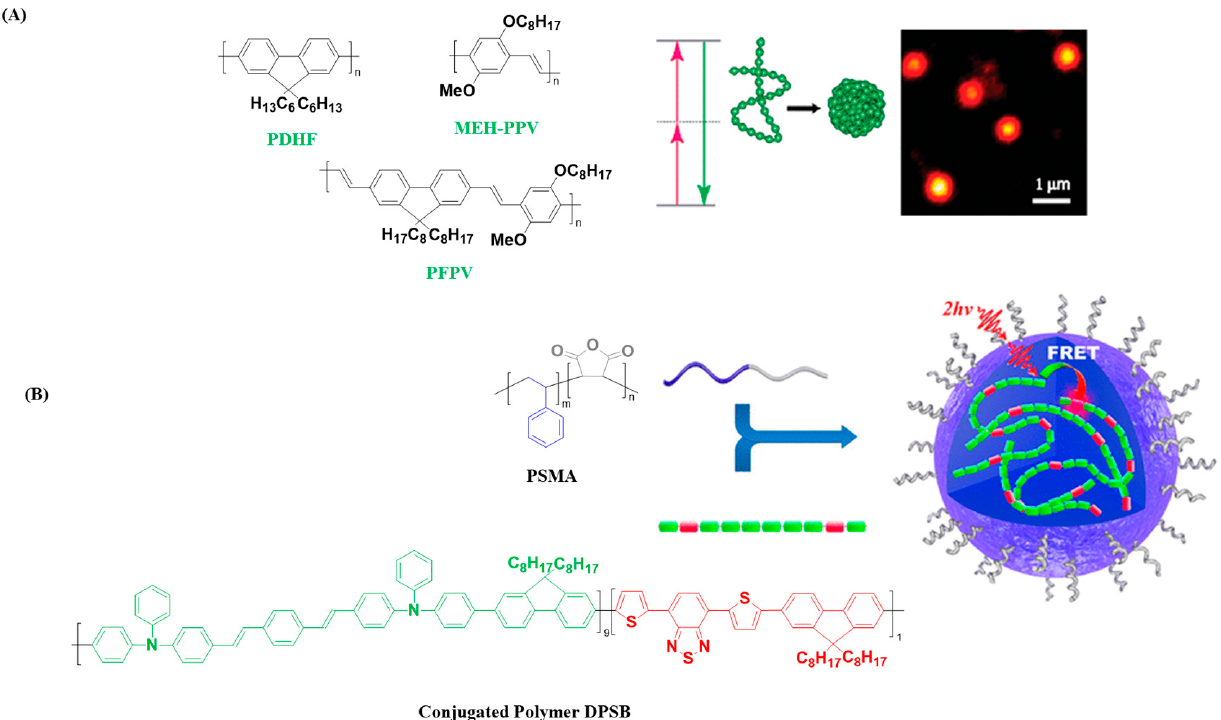
Figure 4. ( A ) Chemical structure of conjugated polymers (PDHF, MEH-PPV, and PFPV), and schematic illustration of formation of CNPs and fluorescence image of single PFPV particle immobilized on a glass coverslip obtained using two-photon excitation (800 nm). Adapted with permission from ref. [46]. Copyright 2007 American Chemical Society. ( B ) Chemical structures of conjugated polymer DPSB, amphiphilic block copolymer PSMA, and schematic illustration of DPSB-loaded CNPs. Adapted with permission from ref. [47] Copyright 2015 American Chemical Society.